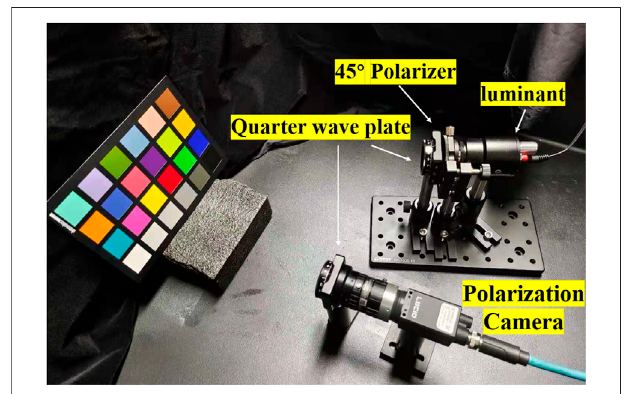
FIGURE 8 | The polarization